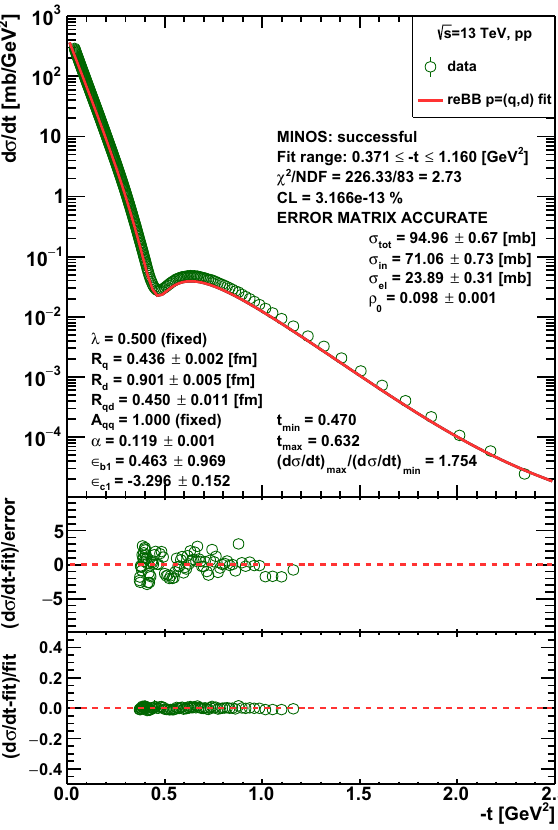
√ s = 7 TeV Fig. 5 The fit of the ReBB model to the pp TOTEM data in the range of 0 . 37 ≤ − t ≤ 1 . 2 GeV 2 [8]. The fit includes the t -dependent statistical (type A) and systematic (type B) uncertainties, the normalization (type C) uncertainty and the experimental values of the total cross section and parameter ρ 0 with their full error according to Eq. (6). The fit parameters do not represent the data in a statisti- cally acceptable manner, given that CL (cid:8) 0.1%. Otherwise, same as Fig. 1